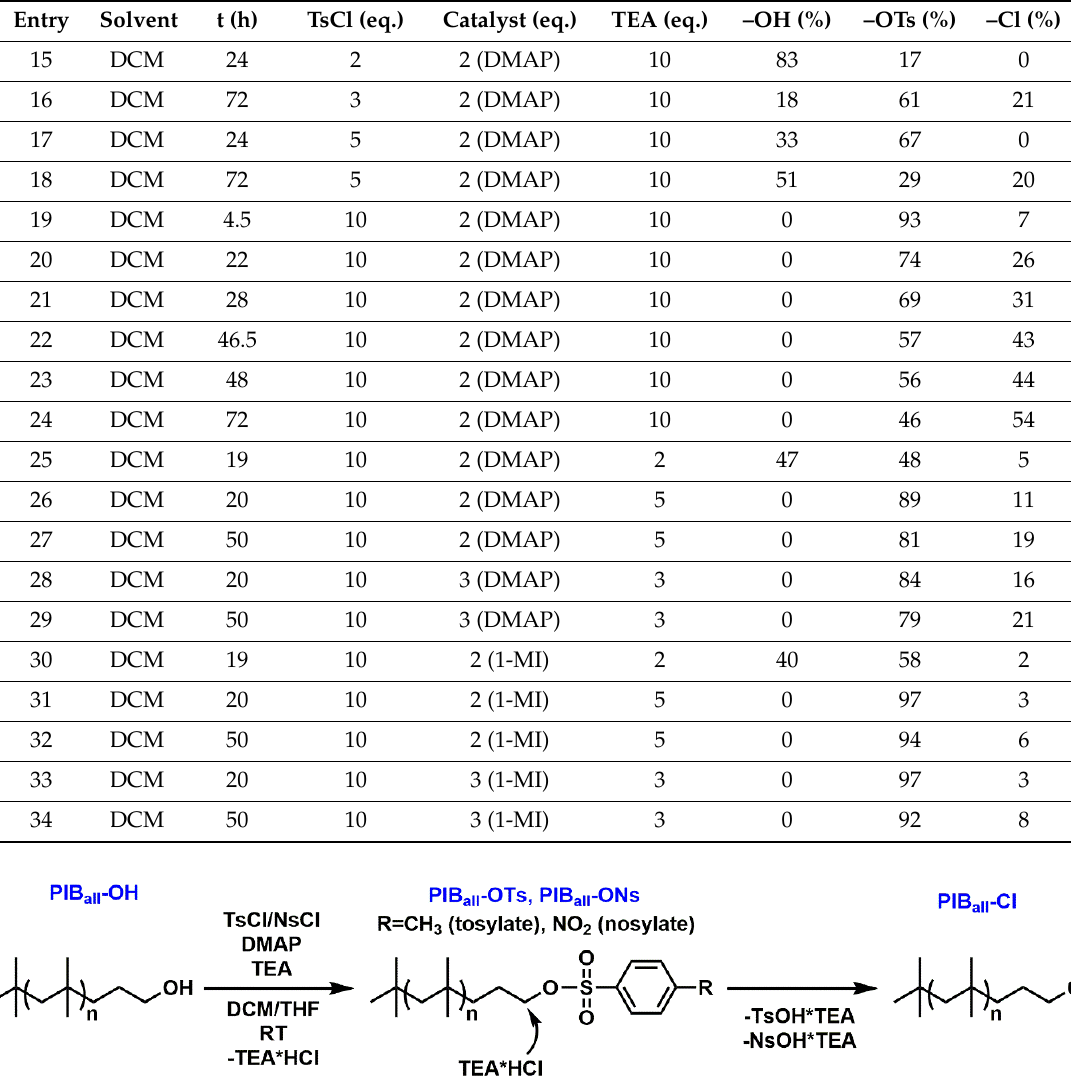
Table 3. The e ff ect of the reaction conditions on the tosylation of PIB all -OH at room